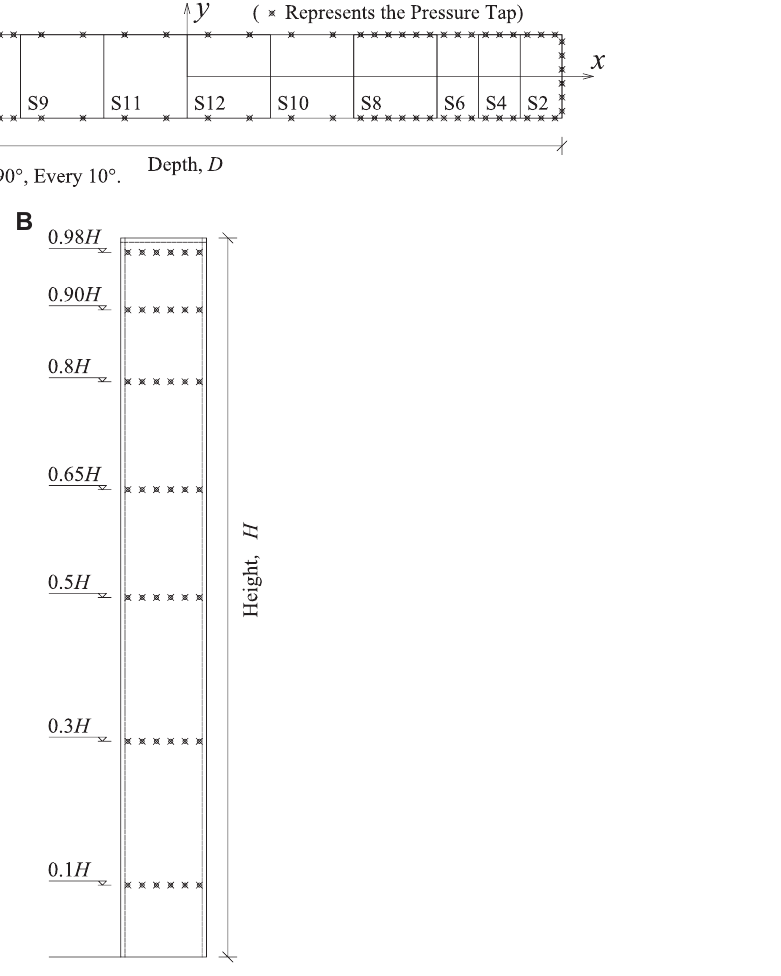
FIGURE 2 | (A) Plan view and (B) side view of the model con fi guration for D/B (cid:1) 9, including the de fi nition of coordinate system, wind direction, and the layout of pressure taps on each section.